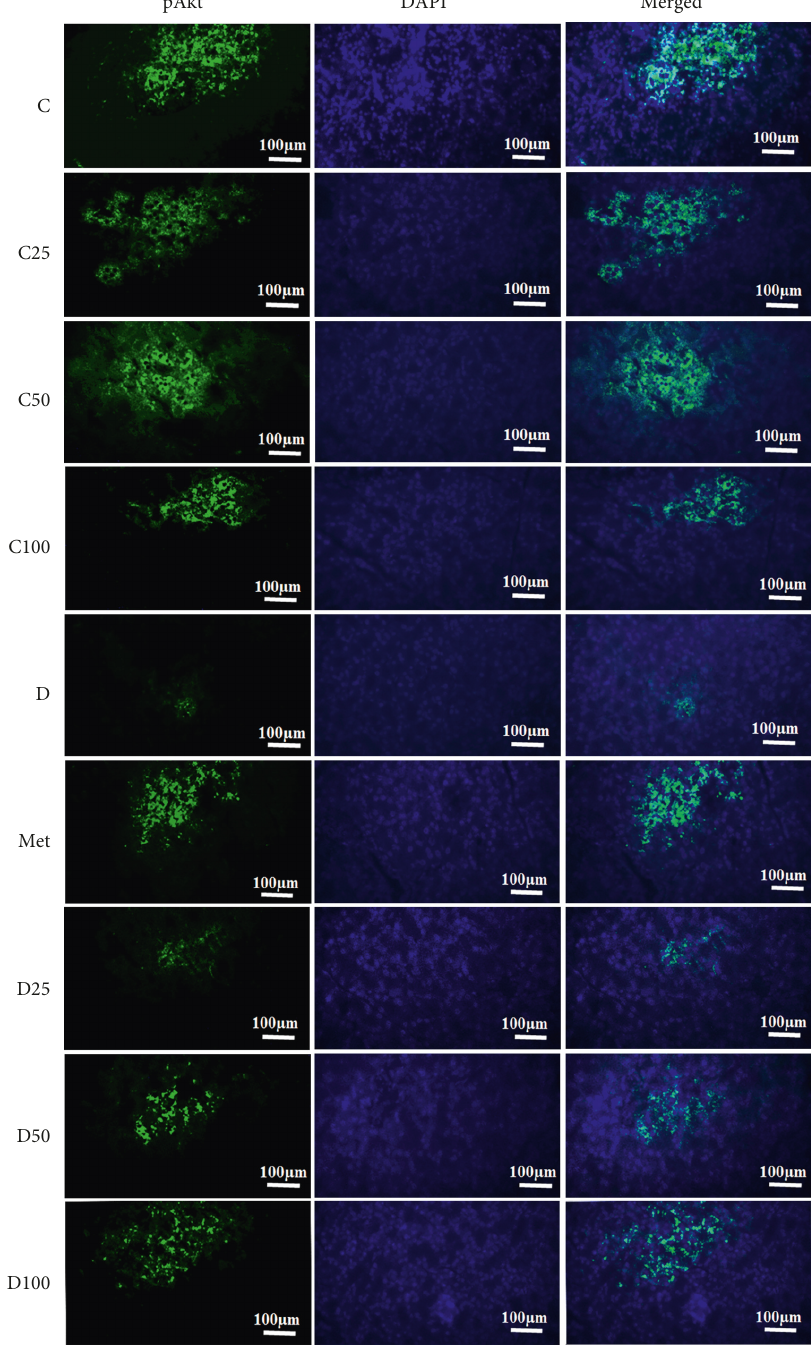
Figure 3: Fluorescence immunocytochemistry analysis of phospho-Akt. C: control rats, D: the sham or diabetic rats, MET: diabetic rats +metformin (55mg/kg), C25: control rats +p-cymene (25mg/kg), C50: control rats+ p-cymene (50mg/kg), C100: control rats +p- cymene (100mg/kg), D25: diabetic rats +p-cymene (25mg/kg), D50: diabetic rats+ p-cymene (50 mg/kg), D100: diabetic rats +p-cymene (100mg/kg), and pAkt: phospho-Akt. Magnification 400x. Scale bar 100 μ